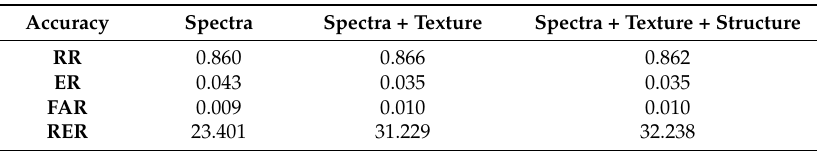
Table 7. RR, ER, and RER with different features combination.